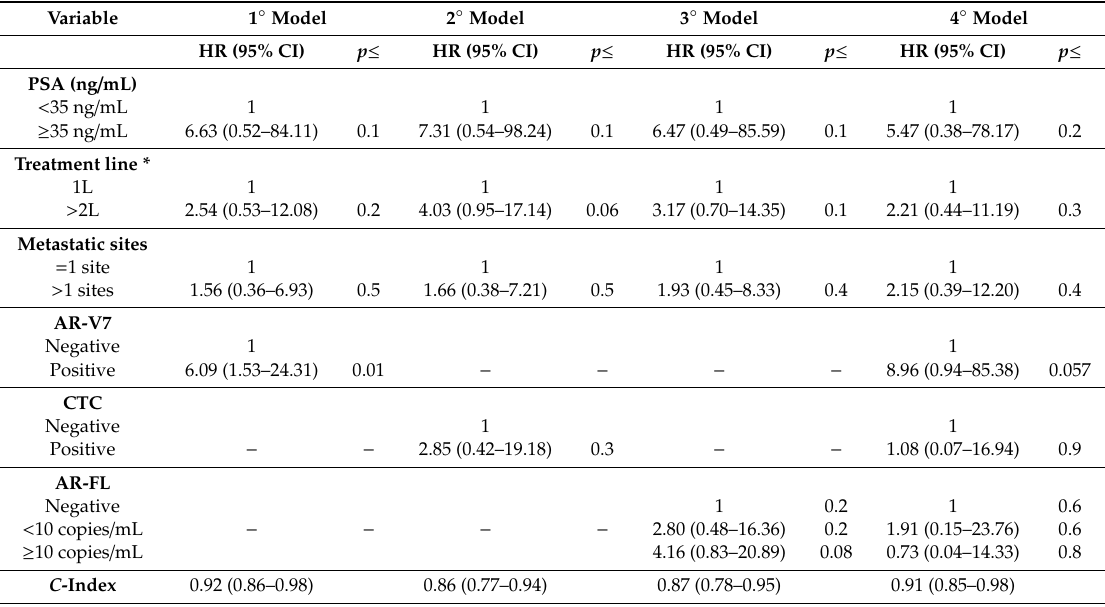
Figure 3. Overall survival according to CTC ( A ), AR-V7 ( B ) and AR-FL ( C ). Table 2. Multivariable Analysis.